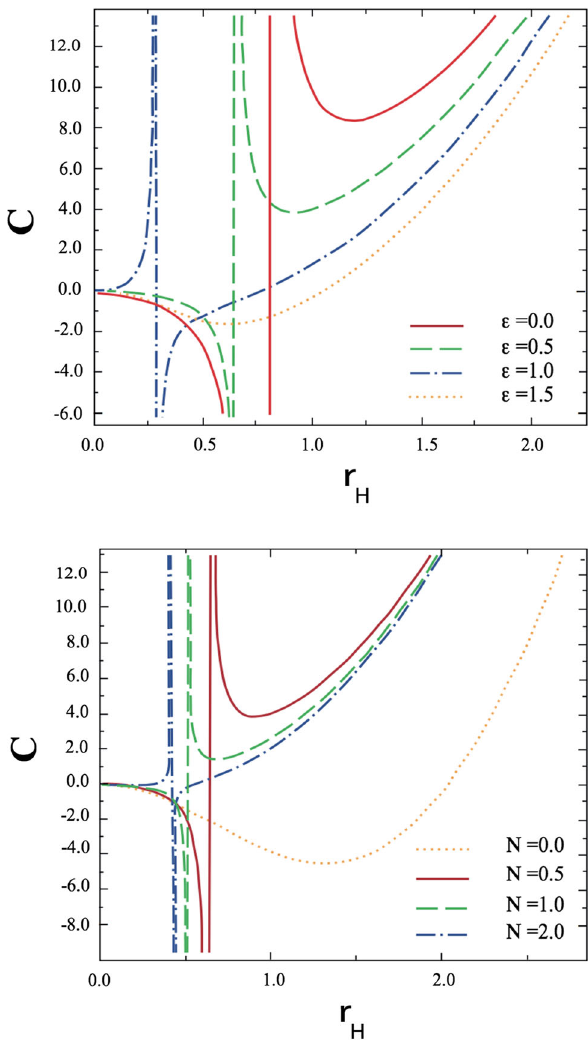
Fig. 3 The Graphs represent C × r H considering the positive cosmo- logical constant. In the upper panel N = 0 . 5 and in the lower panel shows the heat capacity for (cid:2) = 0 .